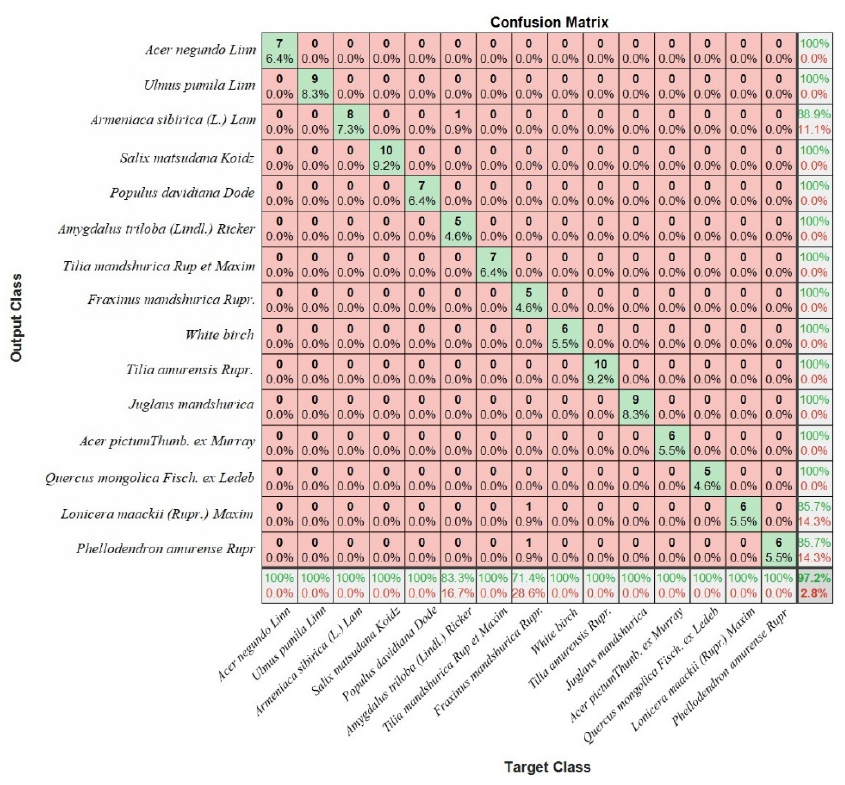
Figure 16. The confusion matrix of leaf small datasets by using ResNet50.